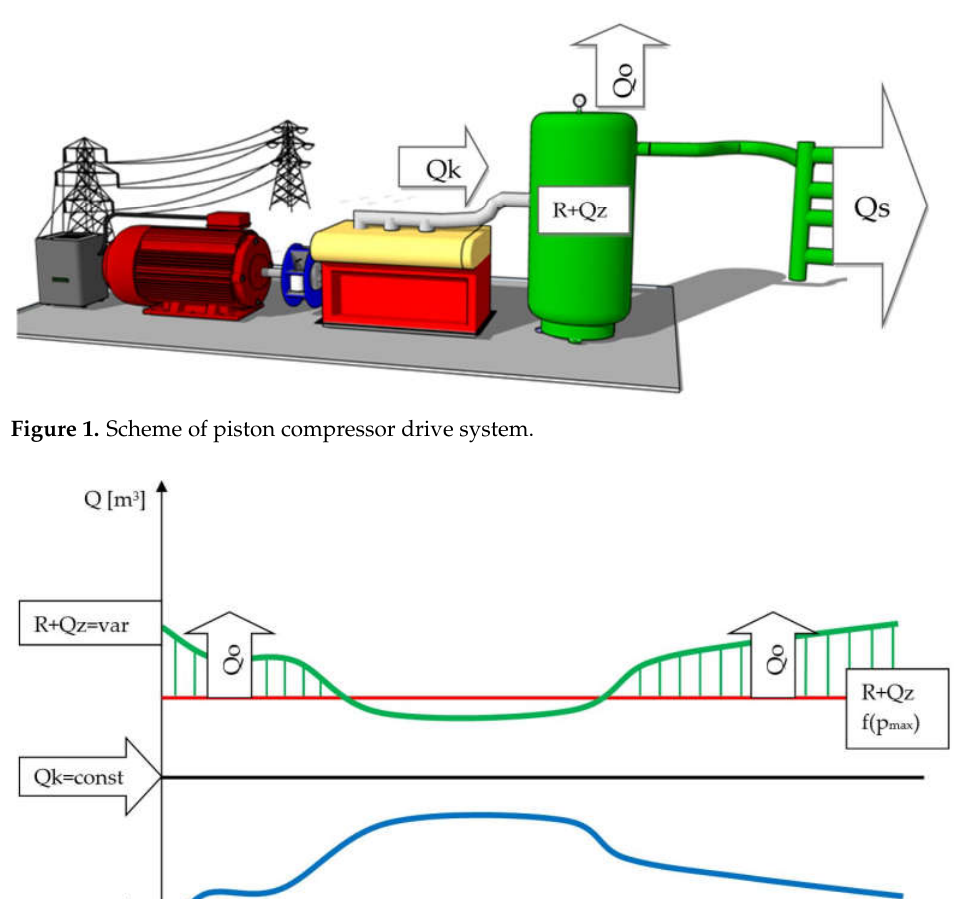
Figure 1. Scheme of piston compressor drive system.